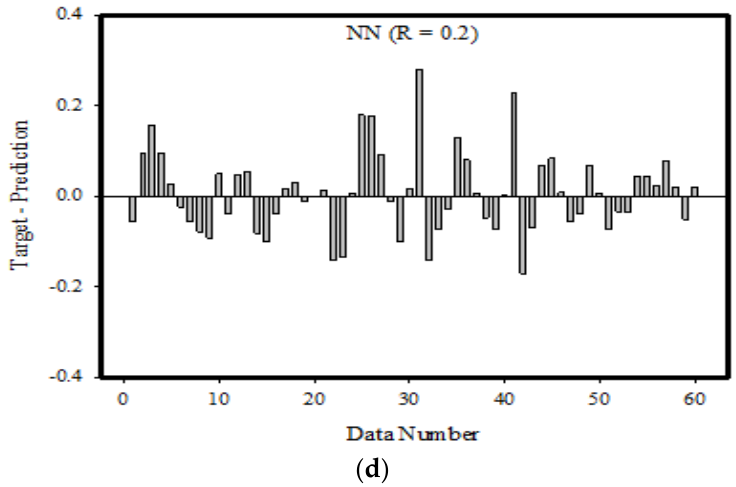
Figure 7. ( a ) The differences between target values and ANN outputs without heat generation effect. ( b ) The differences between target values and ANN outputs with heat generation effect. ( c ) The differences between target values and ANN outputs without radiation effect. ( d ) The differences between target values and ANN outputs with radiation effect.